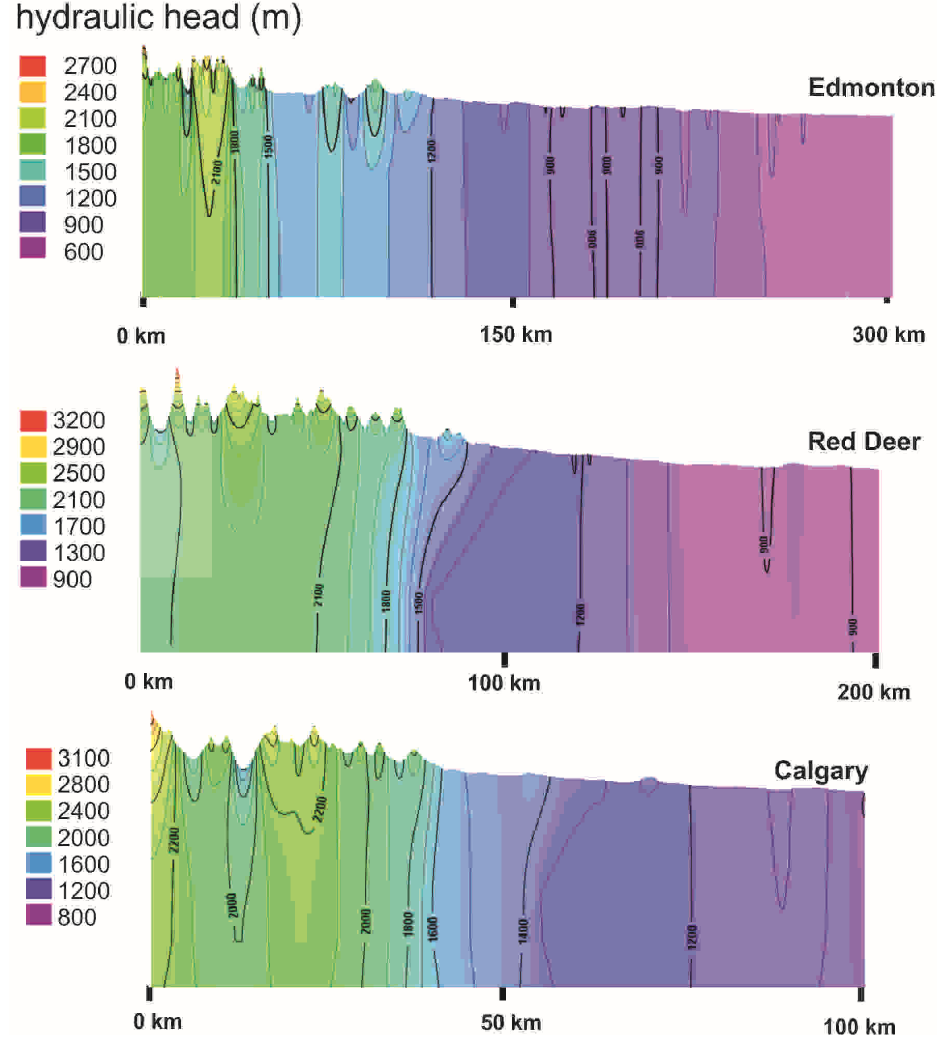
Figure 11. Results of steady-state flow for Model 1, Model 2, and Model 3.